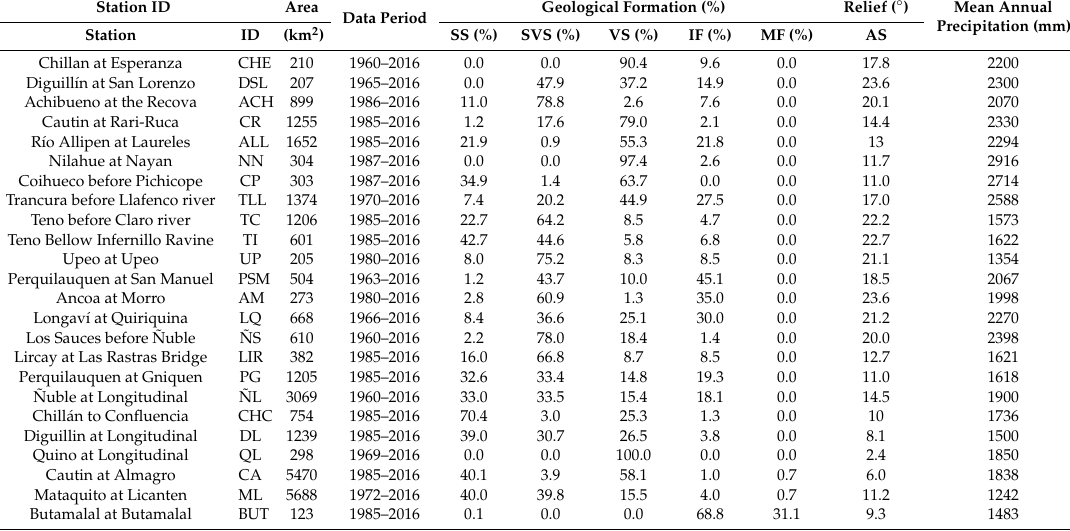
Table 1. Streamflow monitoring stations, watershed type, and data availability in the studied watersheds. In addition, the geological formation percentages and hydro-meteorological information in each watershed are